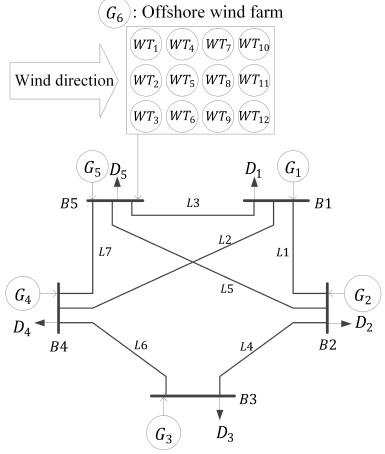
Figure 1. The utilized five-bus test system.